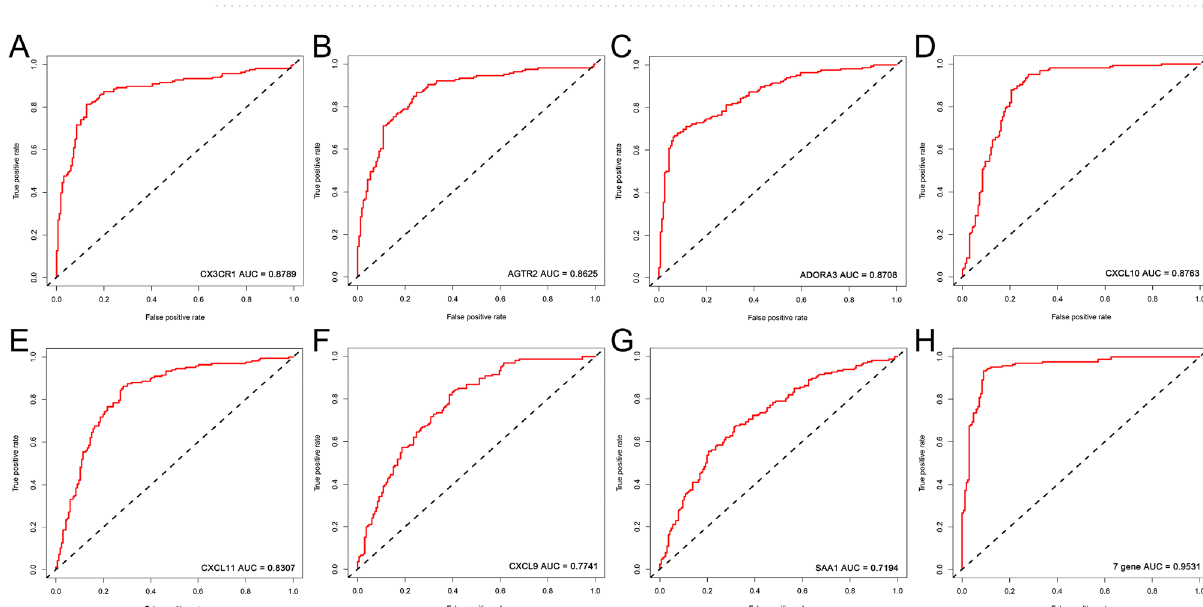
Figure 7. Subject’s operable curve analysis 7 hub genes individually and jointly predict the ability of dilated cardiomyopathy. ( A ) CX3CR1. ( B ) AGTR2. ( C ) ADORA3. ( D ) CXCL10. ( E ) CXCL11. ( F ) CXCL9. ( G ) SAA1. ( H ) Combine 7